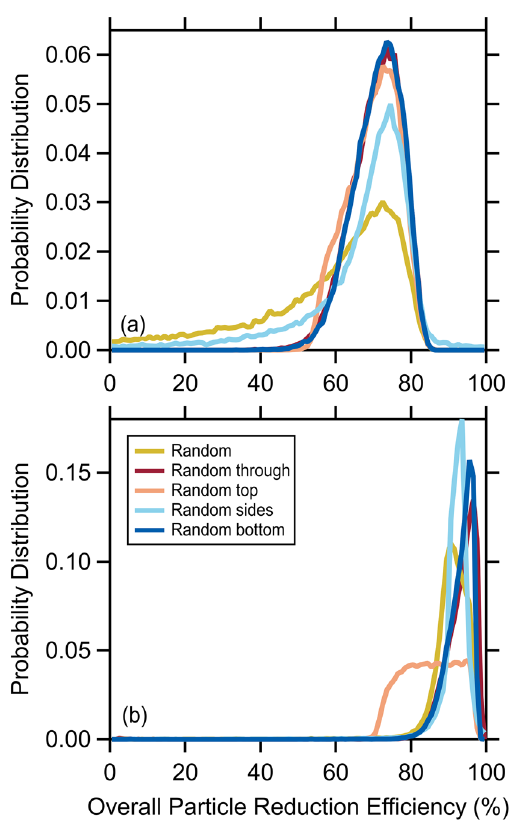
Figure 4. Probability distributions of the particle reduction efficiency for the mask for ( a ) talking and ( b ) coughing, as determined from simulations that use different constraints on the directionality of the expiratory